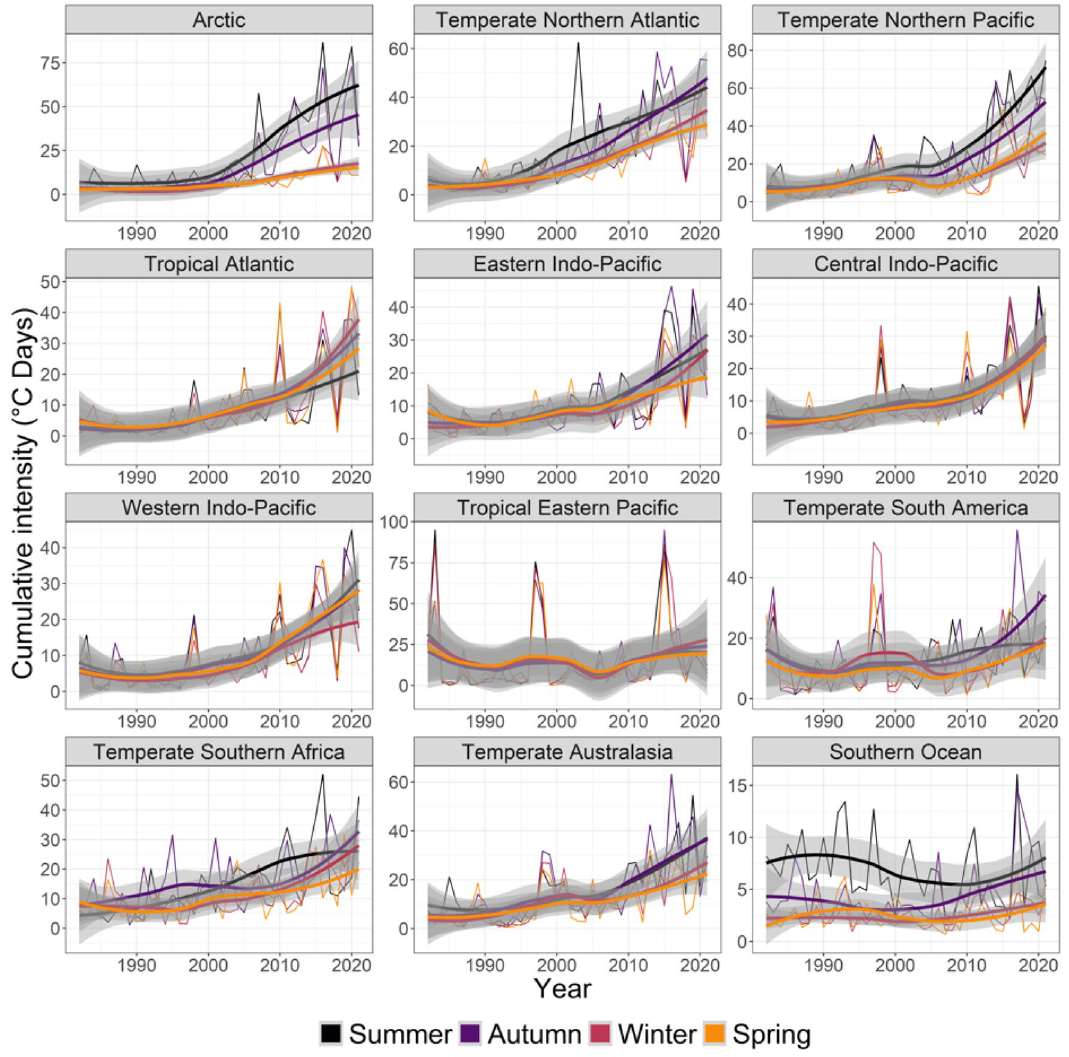
Figure 7. Seasonal trends from 1982 to 2021 in the yearly- and pixel-averaged cumulative intensity (°C days) of marine heatwaves per coastal realm and season. See Fig. 2 caption for more details and Table S4 for specific trendlines, p values and break point